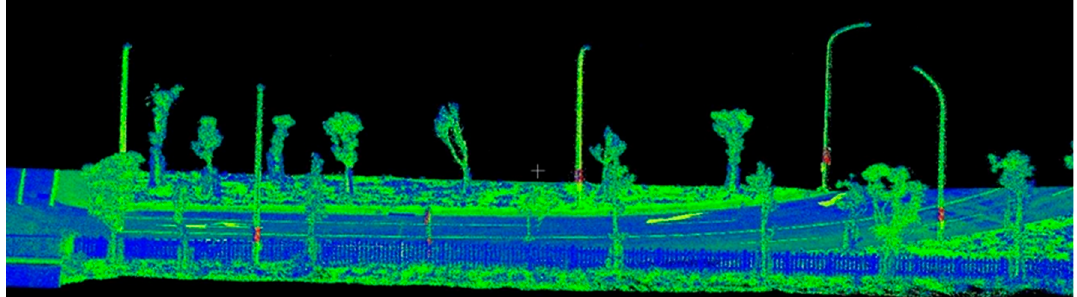
Figure 2. Point cloud data in the experimental field without curb structures.